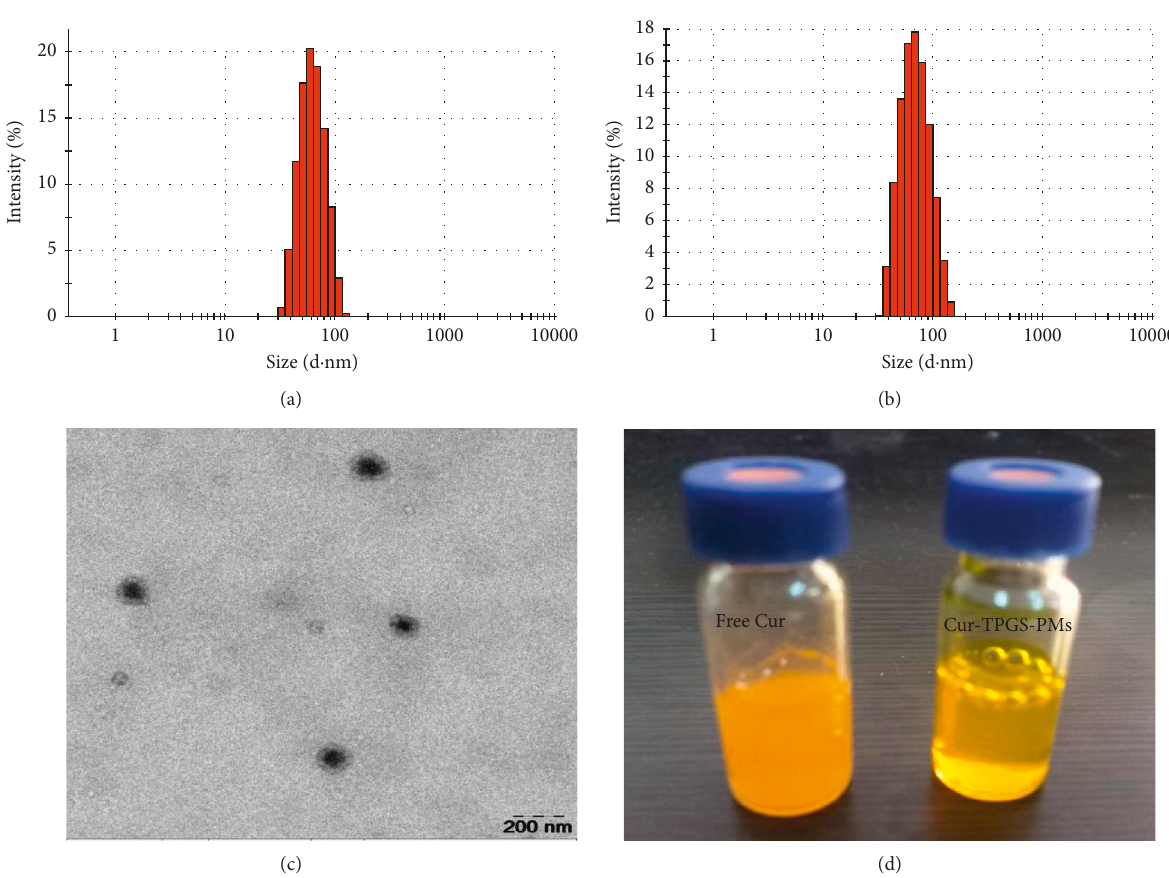
Figure 4: Particle size of blank-TPGS-PMs (a), particle size of Cur-TPGS-PMs (b), TEM image of Cur-TPGS-PMs (c), and colloidal solution of Cur-TPGS-PMs (right), in comparison with free Cur in water (left)